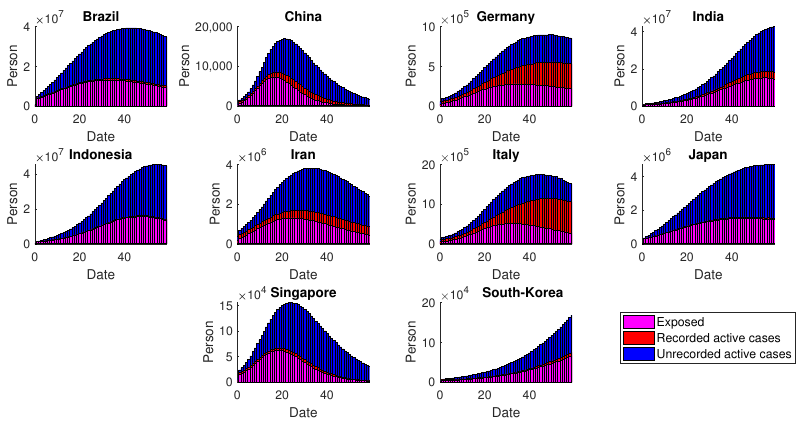
Exposed Recorded active cases Unrecorded active cases